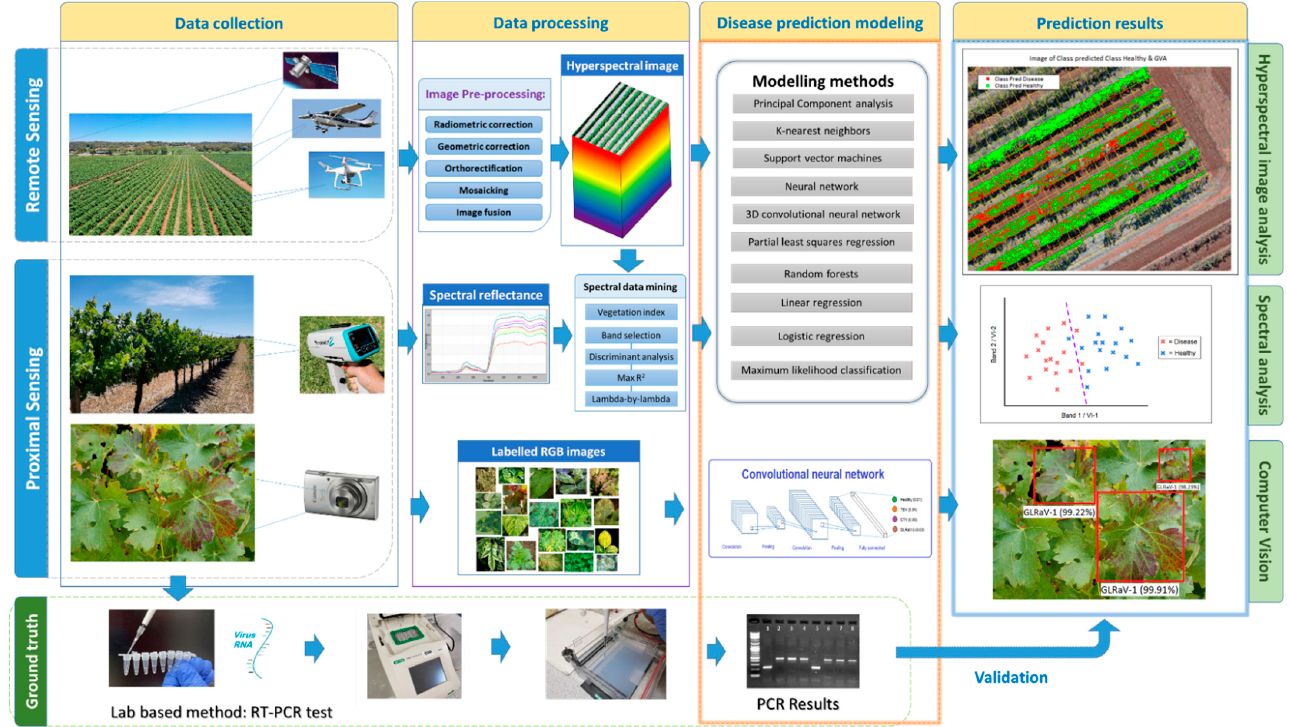
Figure 3. Workflow chart for plant viral disease prediction at different scales. Proximal sensing can obtain detailed spectral information at a point scale or leaf phenotypes at the leaf scale. Airborne remote sensing can be conducted at different spatial and spectral detail to be used for spatial mapping. Different data types involve various classification methods, including object-based methods like computer vision, spectral signal analysis, and pixel-based for multi and hyperspectral images. Indirect methods rely on ground-based information for model development and